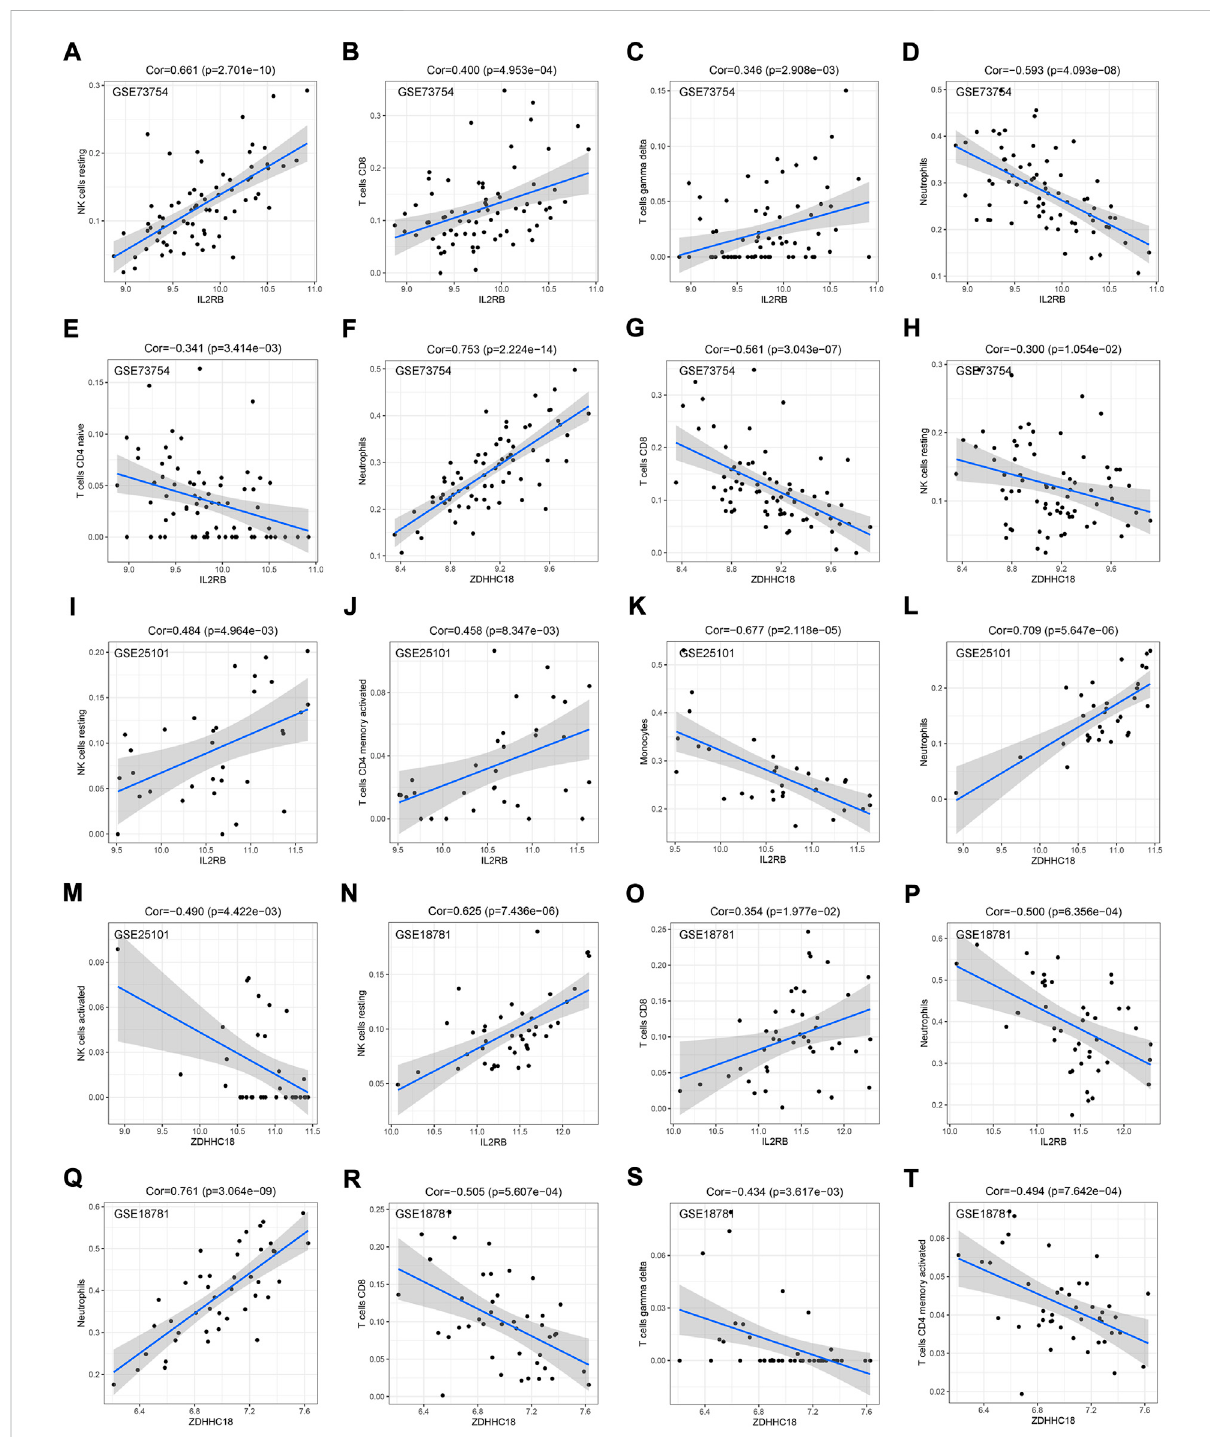
FIGURE 6 CorrelationbetweenhubgenesandIMEcells.ThecorrelationbetweentheexpressionofIL2RBandtheestimatedproportionofrestingNKcells (A) , CD8 + T cells (B) , gamma-delta T cells (C) , neutrophils (D) , and native CD4 T cells (E) by CIBERSORT in GSE73754. The correlation between the expression of ZDHHC18 and the estimated proportions of neutrophils (F) , CD8 + T cells (G) , and resting NK cells (H) by CIBERSORT in GSE73754. The correlation between the expression of IL2RB and the estimated proportions of resting NK cells (I) , activated CD4 + memory T cells (J) , and monocytes (K) by CIBERSORT in GSE25101. The correlation between the expression of ZDHHC18 and the estimated proportions of neutrophils (L) andactivatedNKcells (M) byCIBERSORTinGSE25101.ThecorrelationbetweentheexpressionofIL2RBandtheestimatedproportionsofrestingNK cells (N) , CD8 + T cells (O) , and neutrophils (P) by CIBERSORT in GSE18781. The correlation between the expression of ZDHHC18 and the estimated proportions of neutrophils (Q) , CD8 + T cells (R) , gamma-delta T cells (S) , and activated CD4 + memory T cells (T) by CIBERSORT in